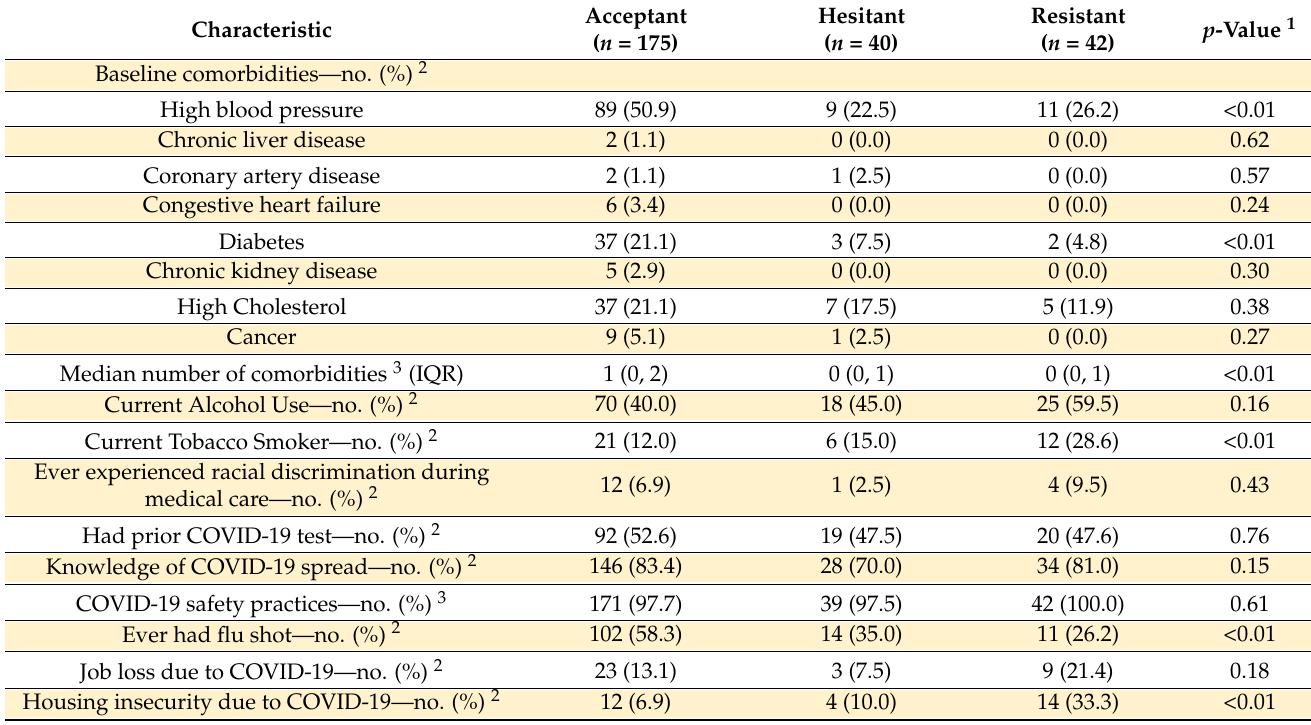
Table 2. Chronic health conditions, health behaviors, beliefs, and experiences among 257 community participants within the SPARTA and 100 Black Men of Augusta survey by vaccine hesitancy